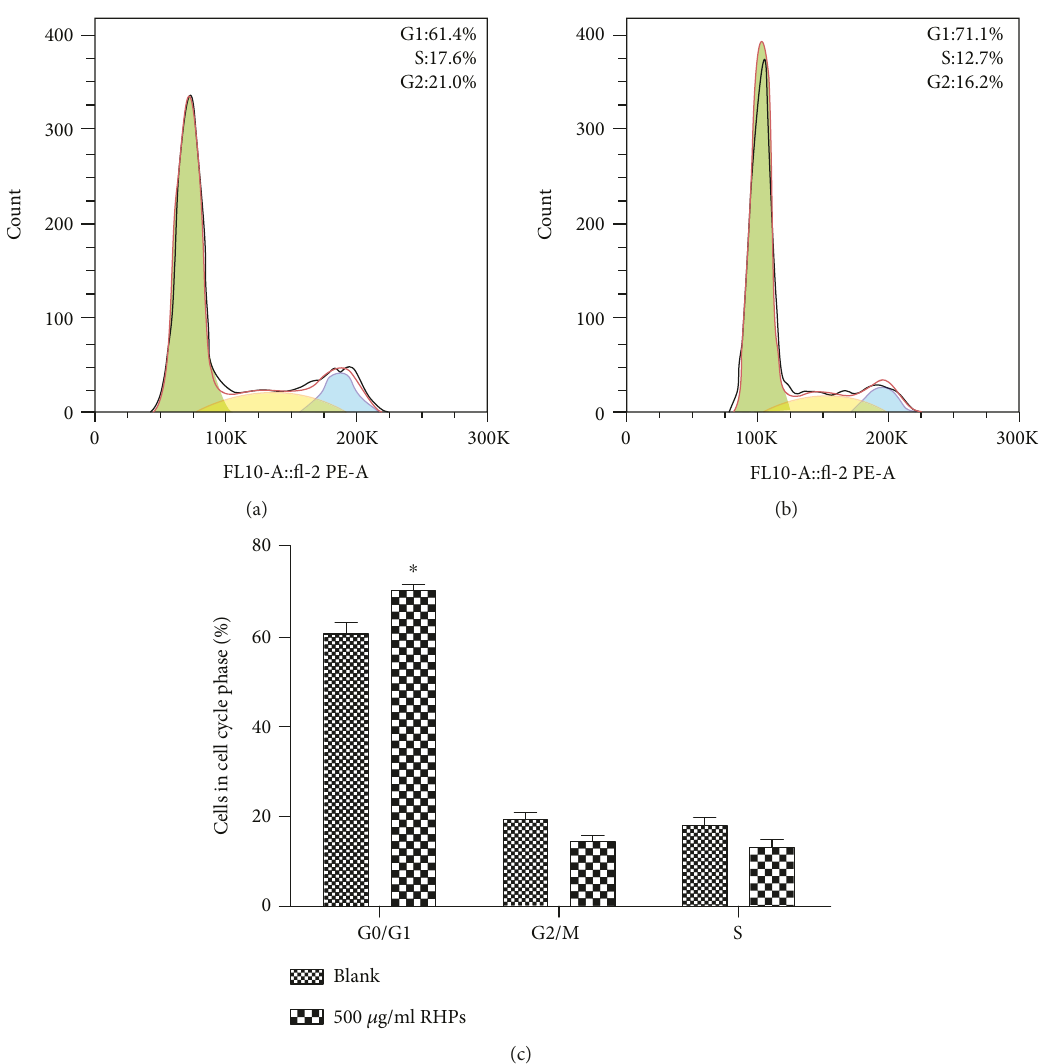
Figure 2: G1 arrest in glioma cells induced by radix hedysari polysaccharide. ∗ P < 0 05 , comparing the blank experimental